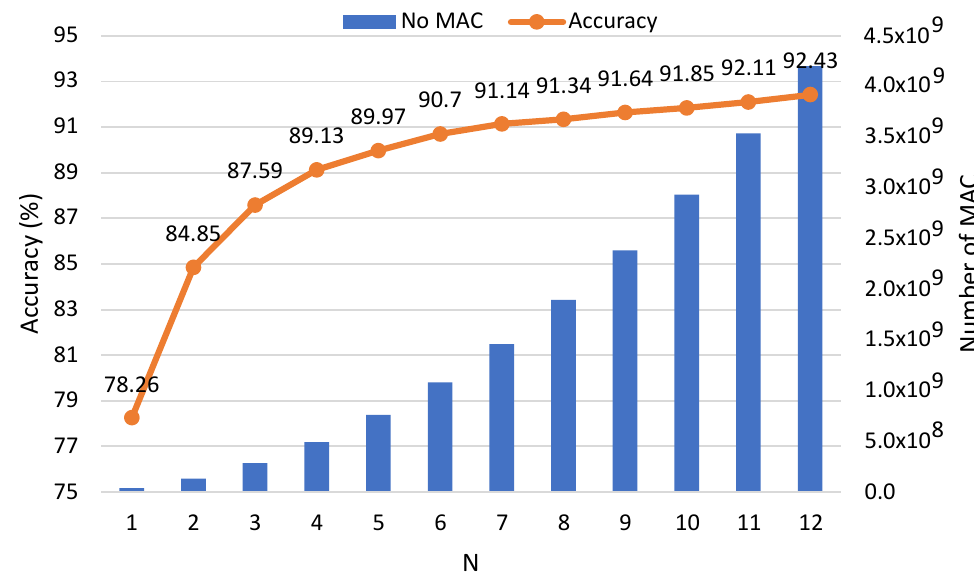
Figure 6. Accuracy results obtained by varying the number of filters by N with the CIFAR-10